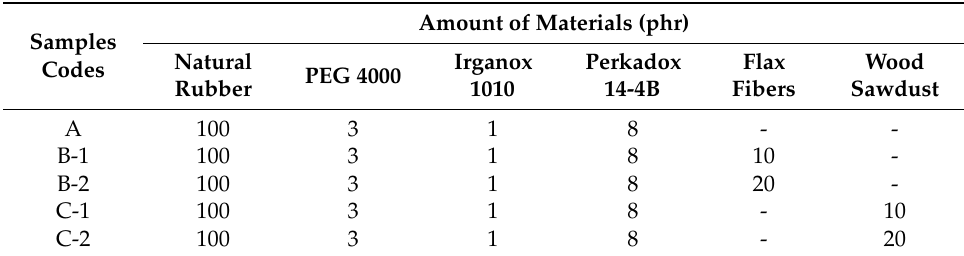
Table 1. The composites samples synthesis details.